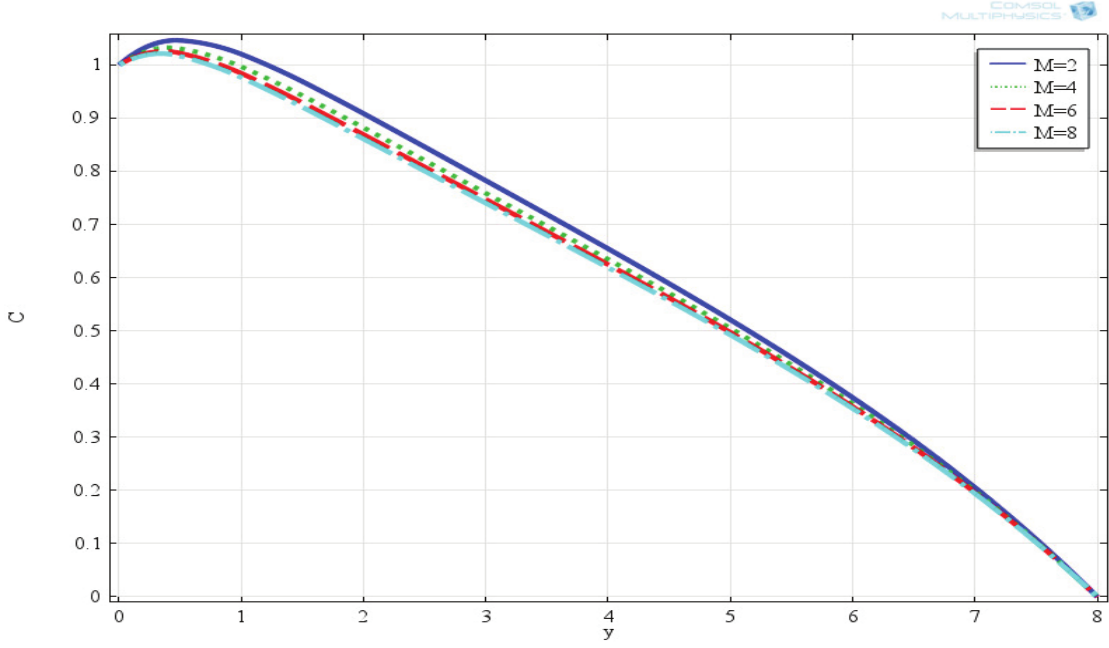
Figure 7: Steady state concentration profiles for different values of M